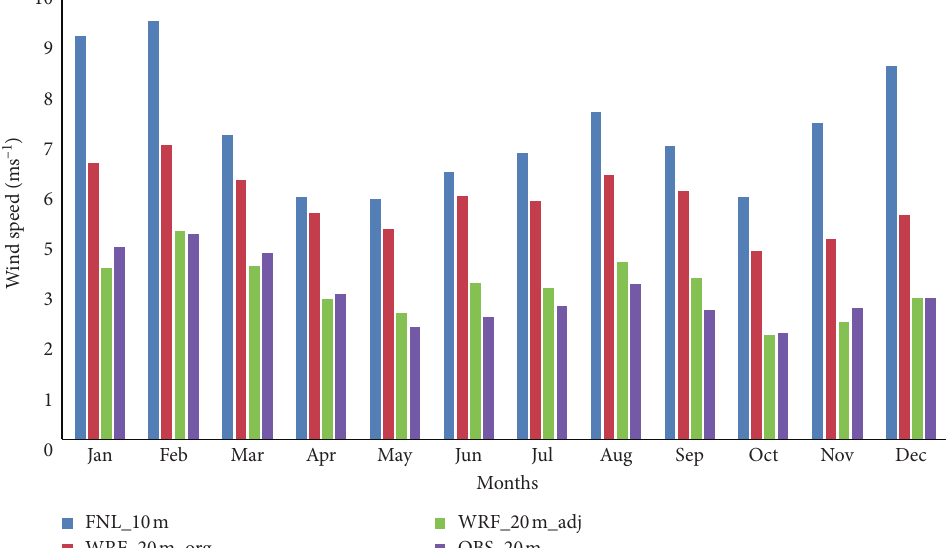
Figure 4: Monthly mean of wind speeds (m s − 1 ) at 10m level from FNL (blue), at 20 m level from observation (purple) and WRF model at 2km resolution for unadjusted (red) and adjusted (green) at Bac Lieu